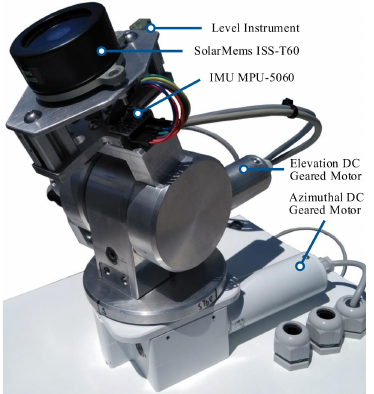
Figure 10. Dual-axis STS obtained by the proposed concurrent